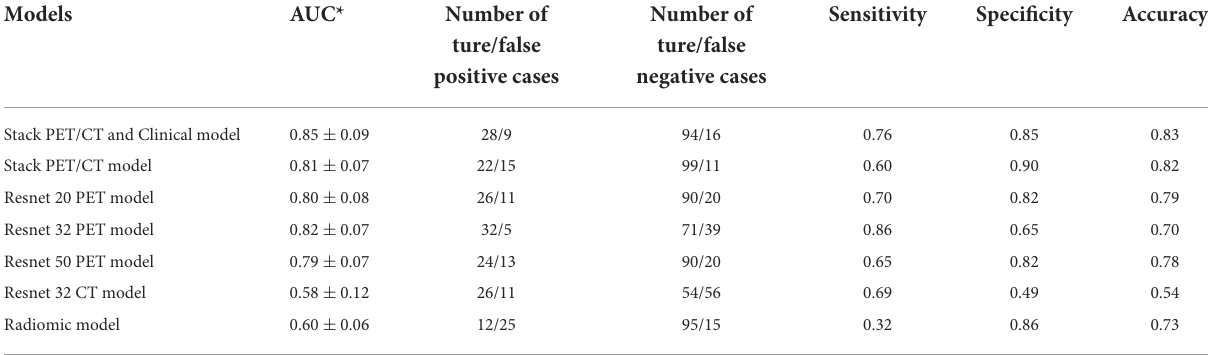
TABLE 3 The performance of different models to classify epidermal growth factor receptor-mutated lesions. Models